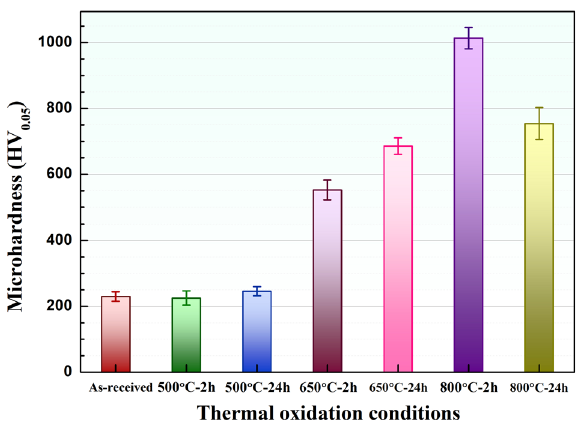
Fig. 3 Microhardness of the as-received and thermally oxidized pure Ti under different conditions. Error bars represent standard deviations of three independent titanium